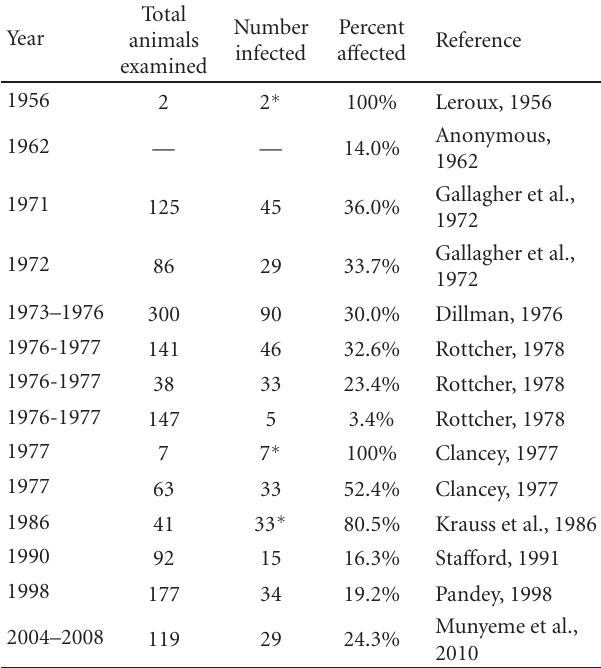
Table 3: Bovine tuberculosis in the Kafue lechwe of the Kafue